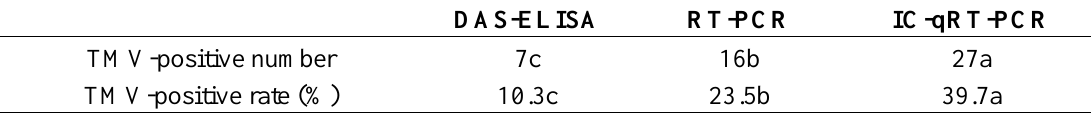
Table 1. Detection of TMV in soil samples by DAS-ELISA, RT-PCR and IC-qRT-PCR.